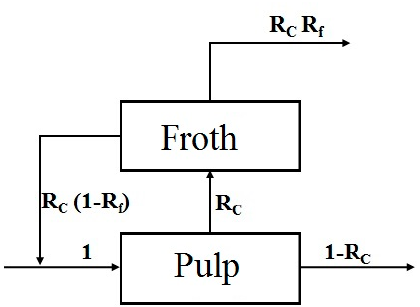
Figure 1. Froth and pulp recovery model [2].